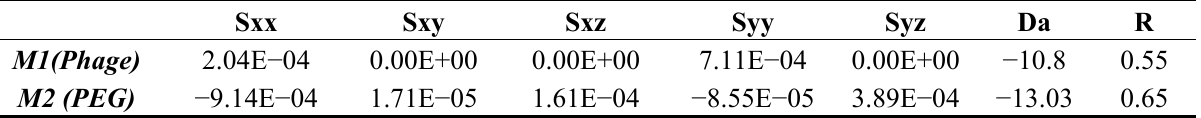
Table 12. Order tensors of Pf2048.1 estimated from 2D-RDC analysis using unassigned RDC data from two alignment media (Phage and